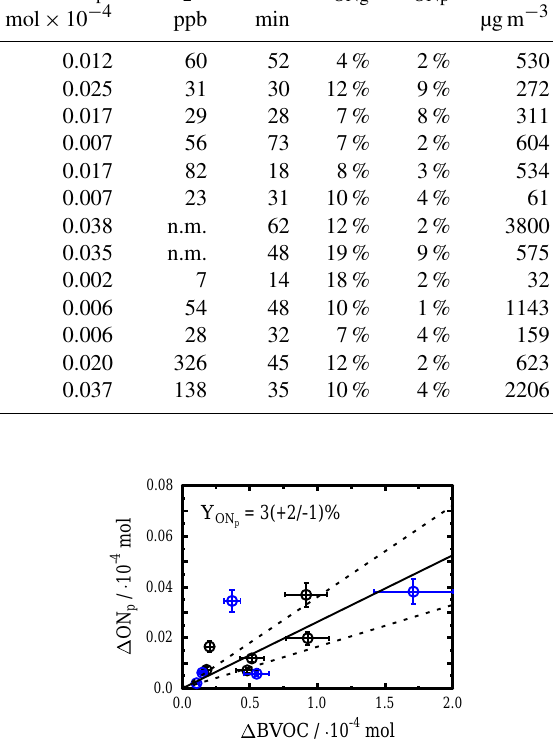
Figure 4. Total wall-loss- and dilution-corrected particle-phase or- ganic nitrate production ( (cid:49) ON p ) as a function of the amount of BVOC consumed ( (cid:49) BVOC) for the unseeded (black circles) and (NH 4 ) 2 SO 4 -seeded experiments (blue circles). The error bars and fits are derived as in Fig.